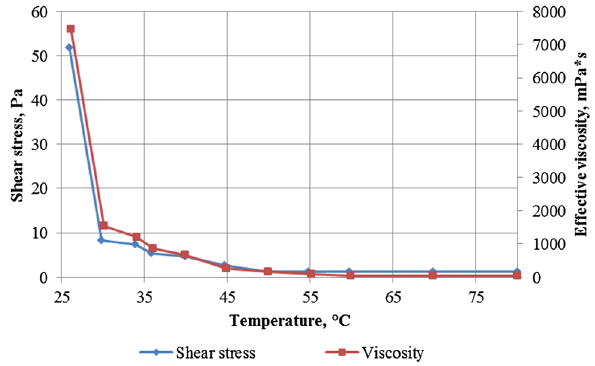
Fig. 6 Effect of temperature on shear stress and effective viscosity